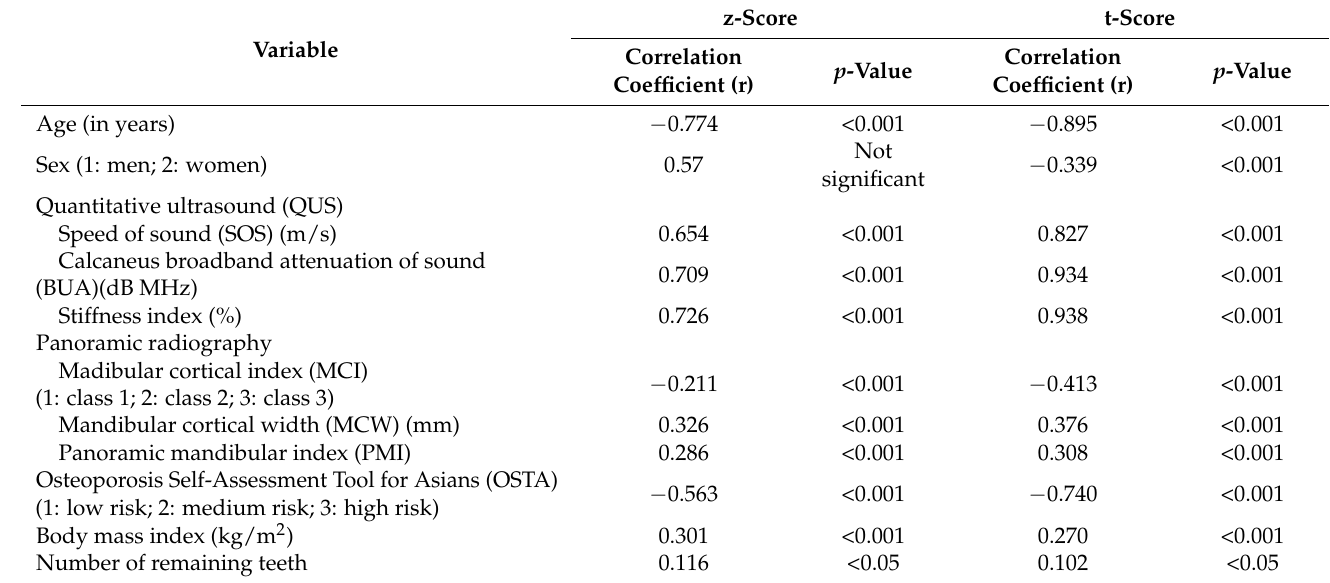
Table 4. Correlations of all variables based on z-score and t-score according to Spearman’s rho correlation coefficient value.